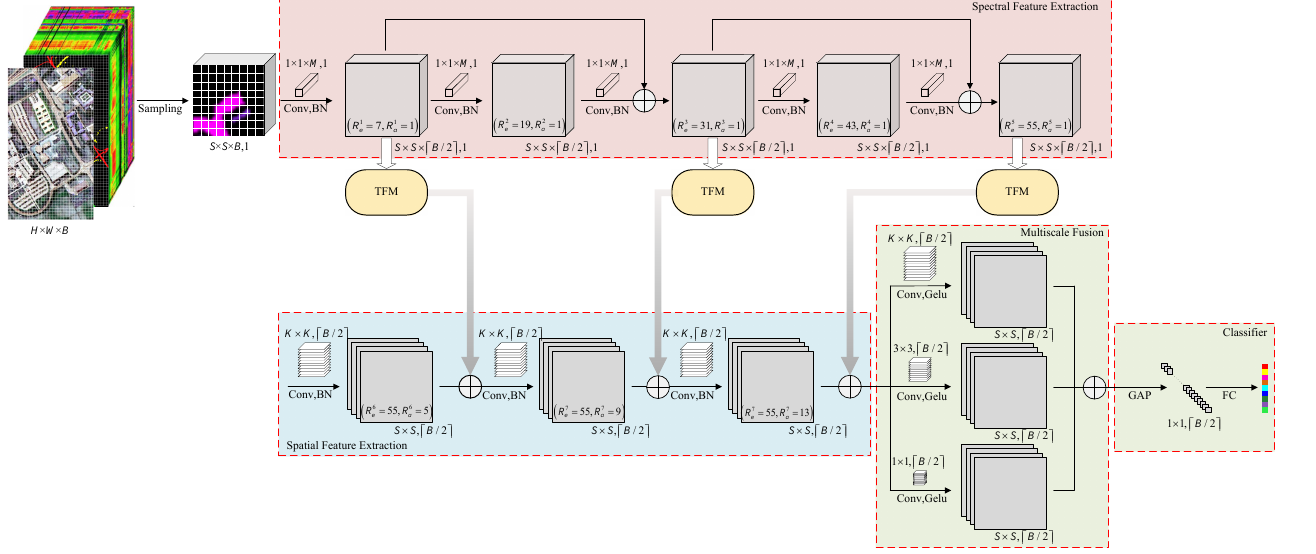
Figure 1. Framework of the proposed LMFN for HSI classification. The upper line shows spectral correlation learning and the lower line concentrates on spatial dependence mapping. TFM blocks are the object-guided fusion mechanism used for spectral–spatial